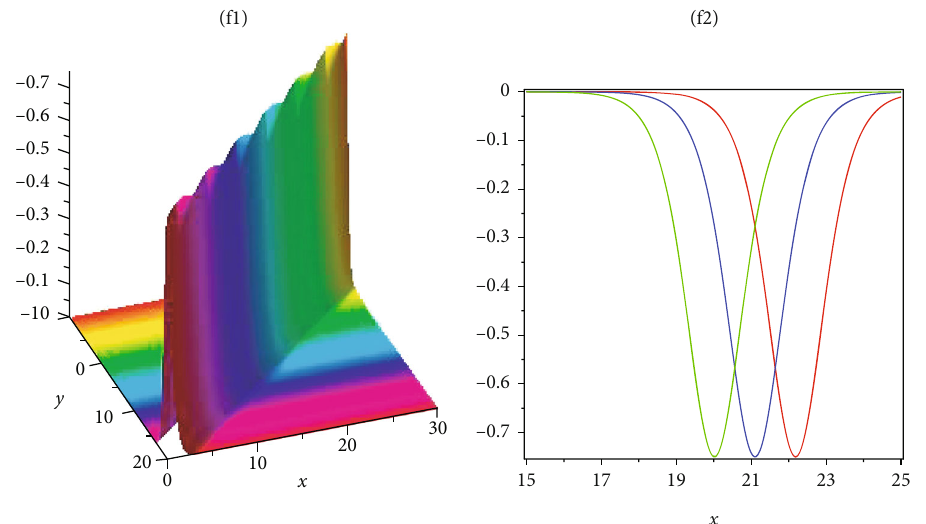
Figure 1: Graph of Eq. (20) for the ( 2 + 1 )-dimensional Benjamin-Ono equation at a = 2, α = 2, β = − 3, c = 2, γ = 2, r = 1, w = 0 : 3, t = 20 and for 2 plot spaces y = − 1, 0, 1 .